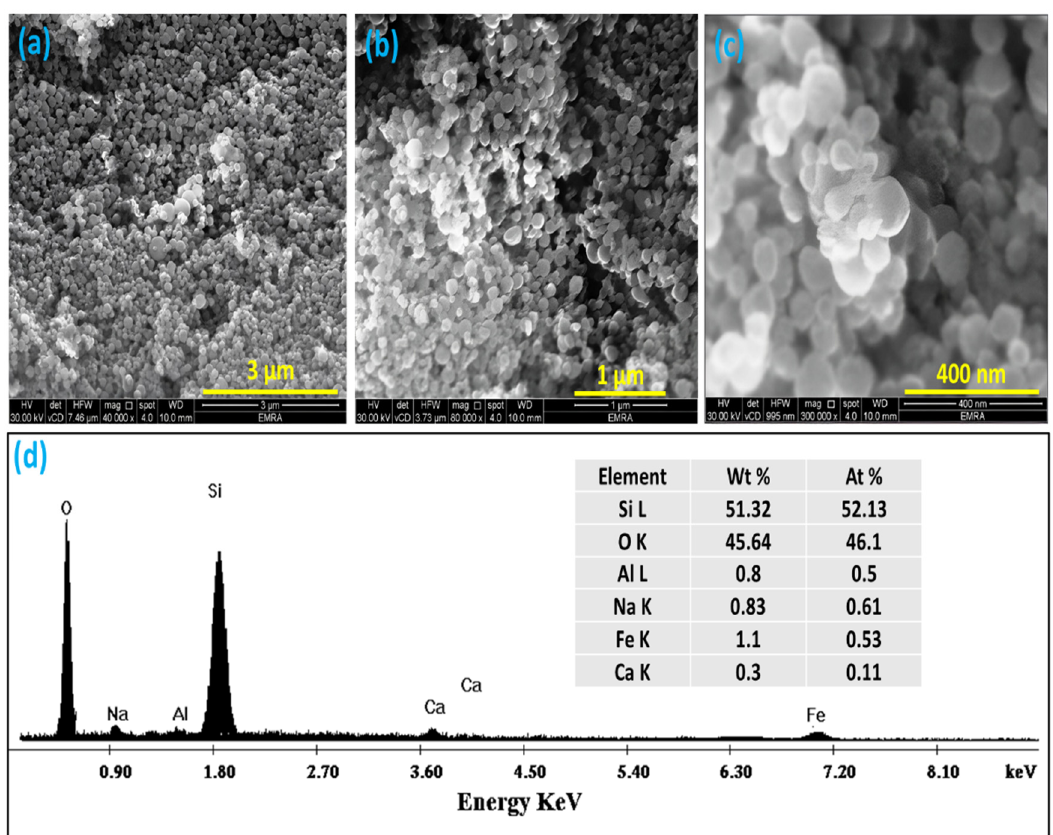
Figure 4. SEM images of the produced SiO 2 NPs at different magnifications: ( a ) 40,000×; ( b ) 80,000×, and ( c ) 300,000×, respectively; ( d ) represent EDX spectrum and corresponding elemental table for the chemical composition of prepared SiO 2 NP sample.